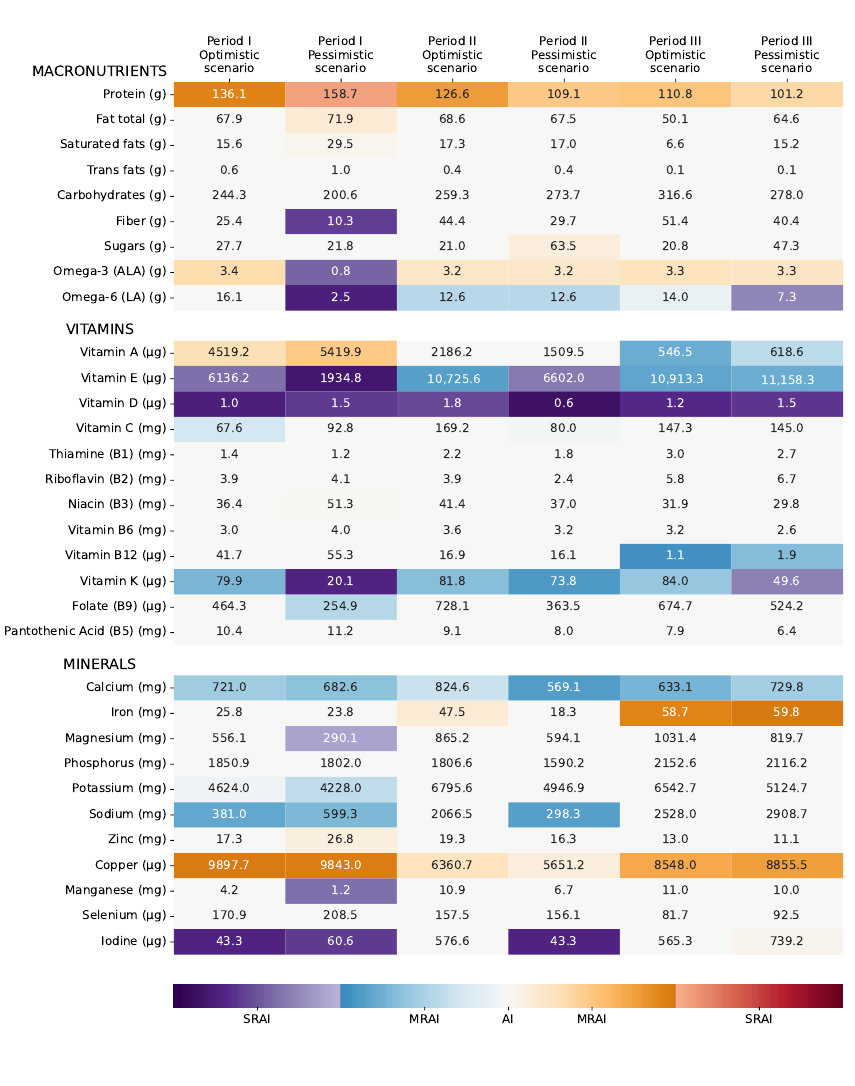
Figure 2. Nutrient distribution in optimistic and pessimistic scenarios for each period. The words ‘moderate(ly)’ and ‘severe(ly)’ are used to refer to MRAIs and